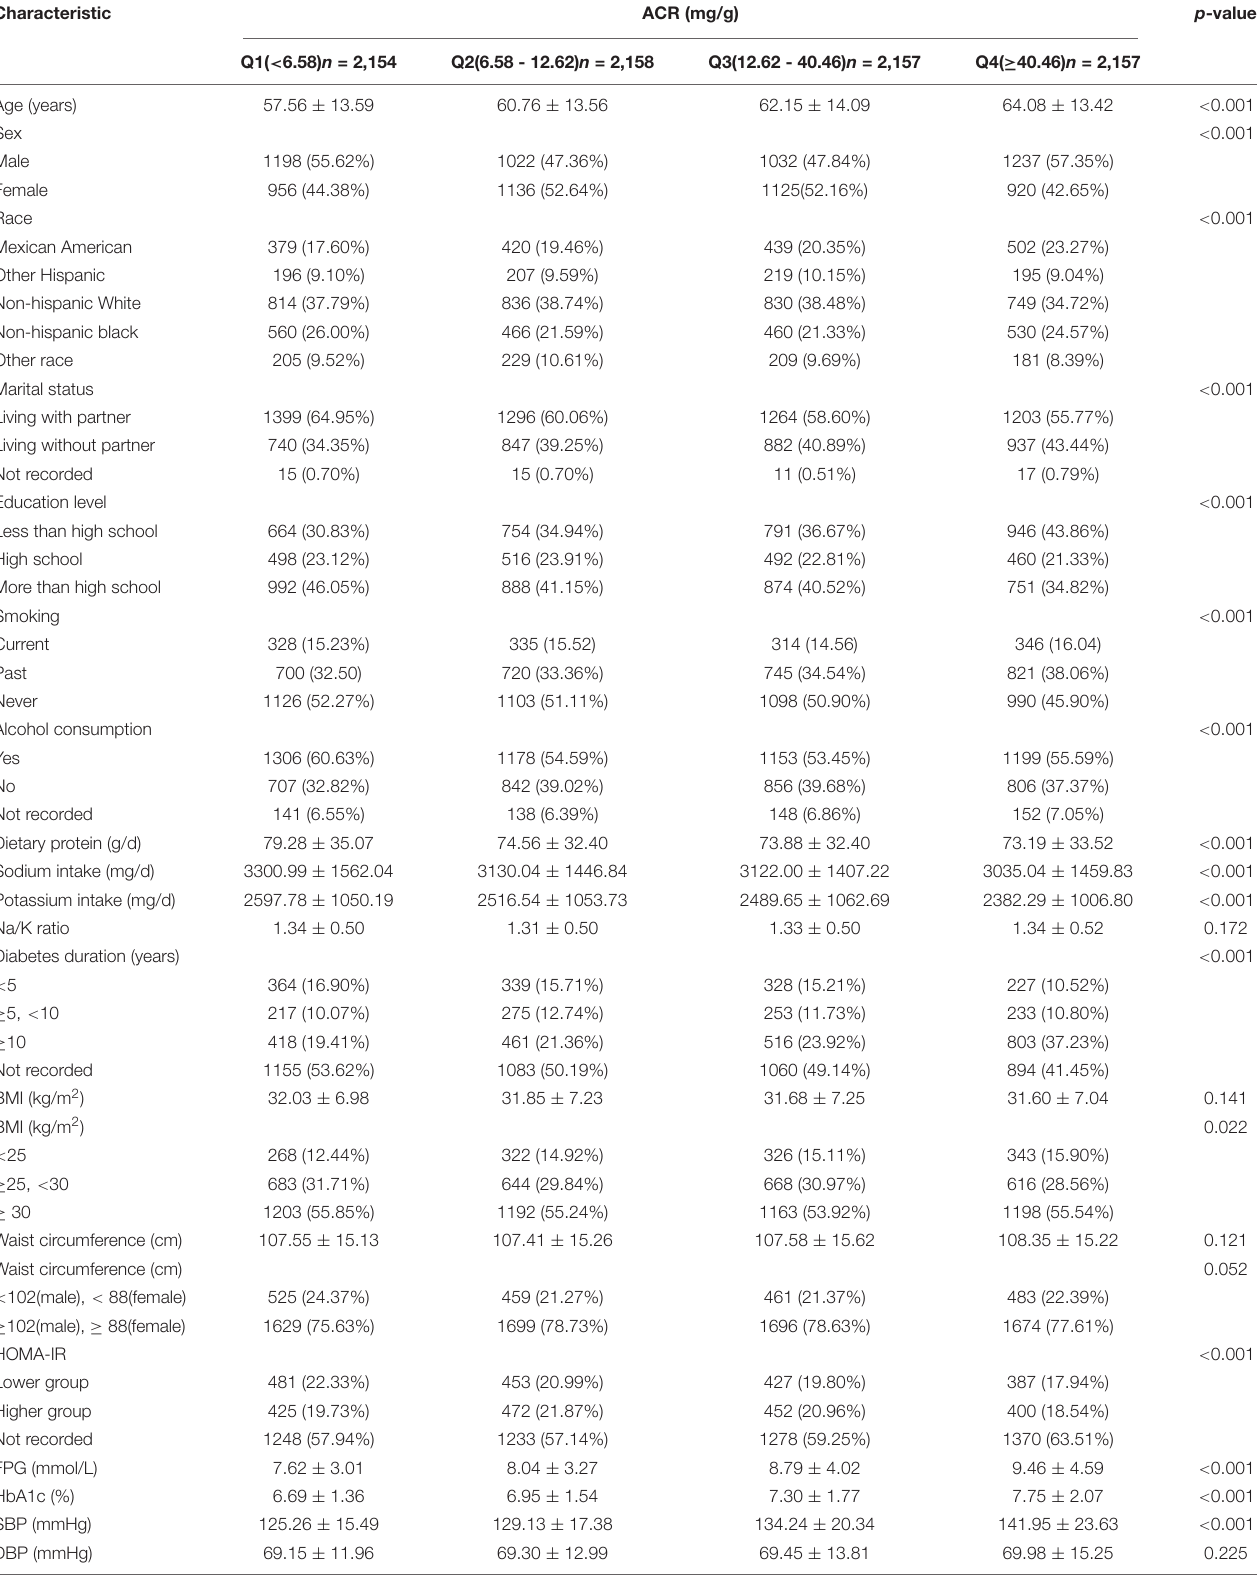
TABLE 1 | The clinical characteristics of enrolled participants were stratified by albumin/creatinine ratio (ACR) quartiles.